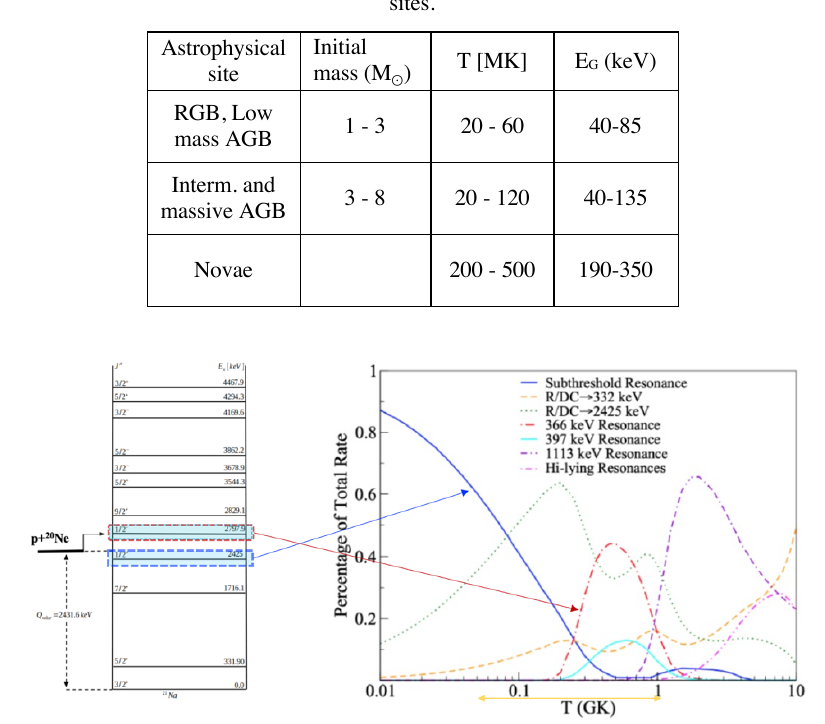
Table 1. Energy and temperature ranges for the 20 Ne(p, g ) 21 Ne reaction in the relevant astrophysical sites.